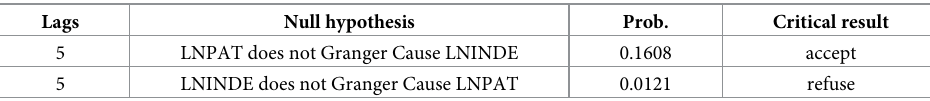
Table 11. Results of granger causality test between LNINDE and LNPAT.